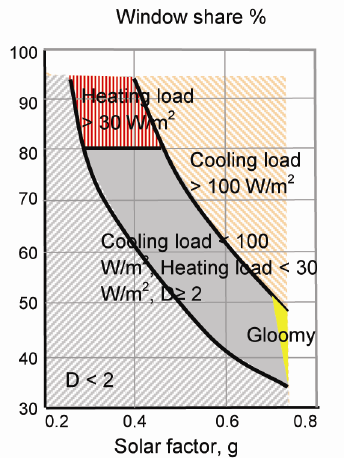
Fig. 16. Possible combinations of window glass share and solar factor that fulfil the requirements of a cooling power